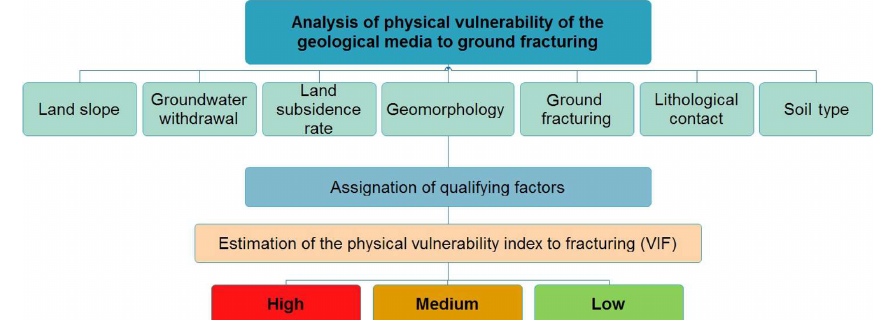
Figure 3. Flowchart for the determination of the physical vulnerability index to fracturing.